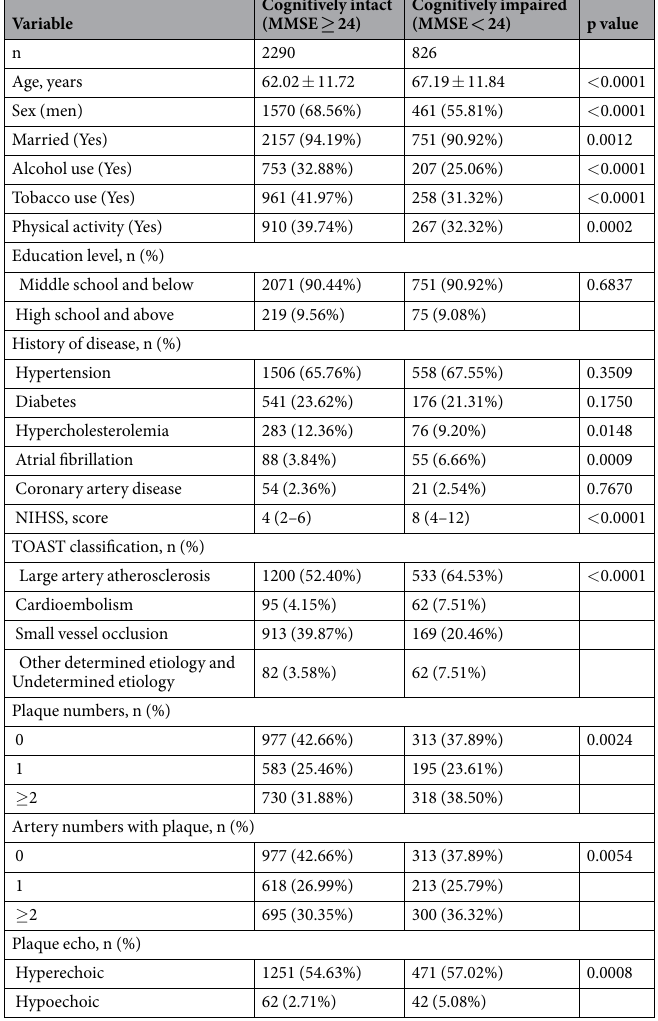
Table 1. Characteristics of patients with and without cognitive impairment in the study population. MMSE: Mini-Mental State Examination; SD = Standard Deviation; NIHSS: National Institutes of Health Stroke Scale; TOAST: Trial of Org 10172 in Acute Stroke